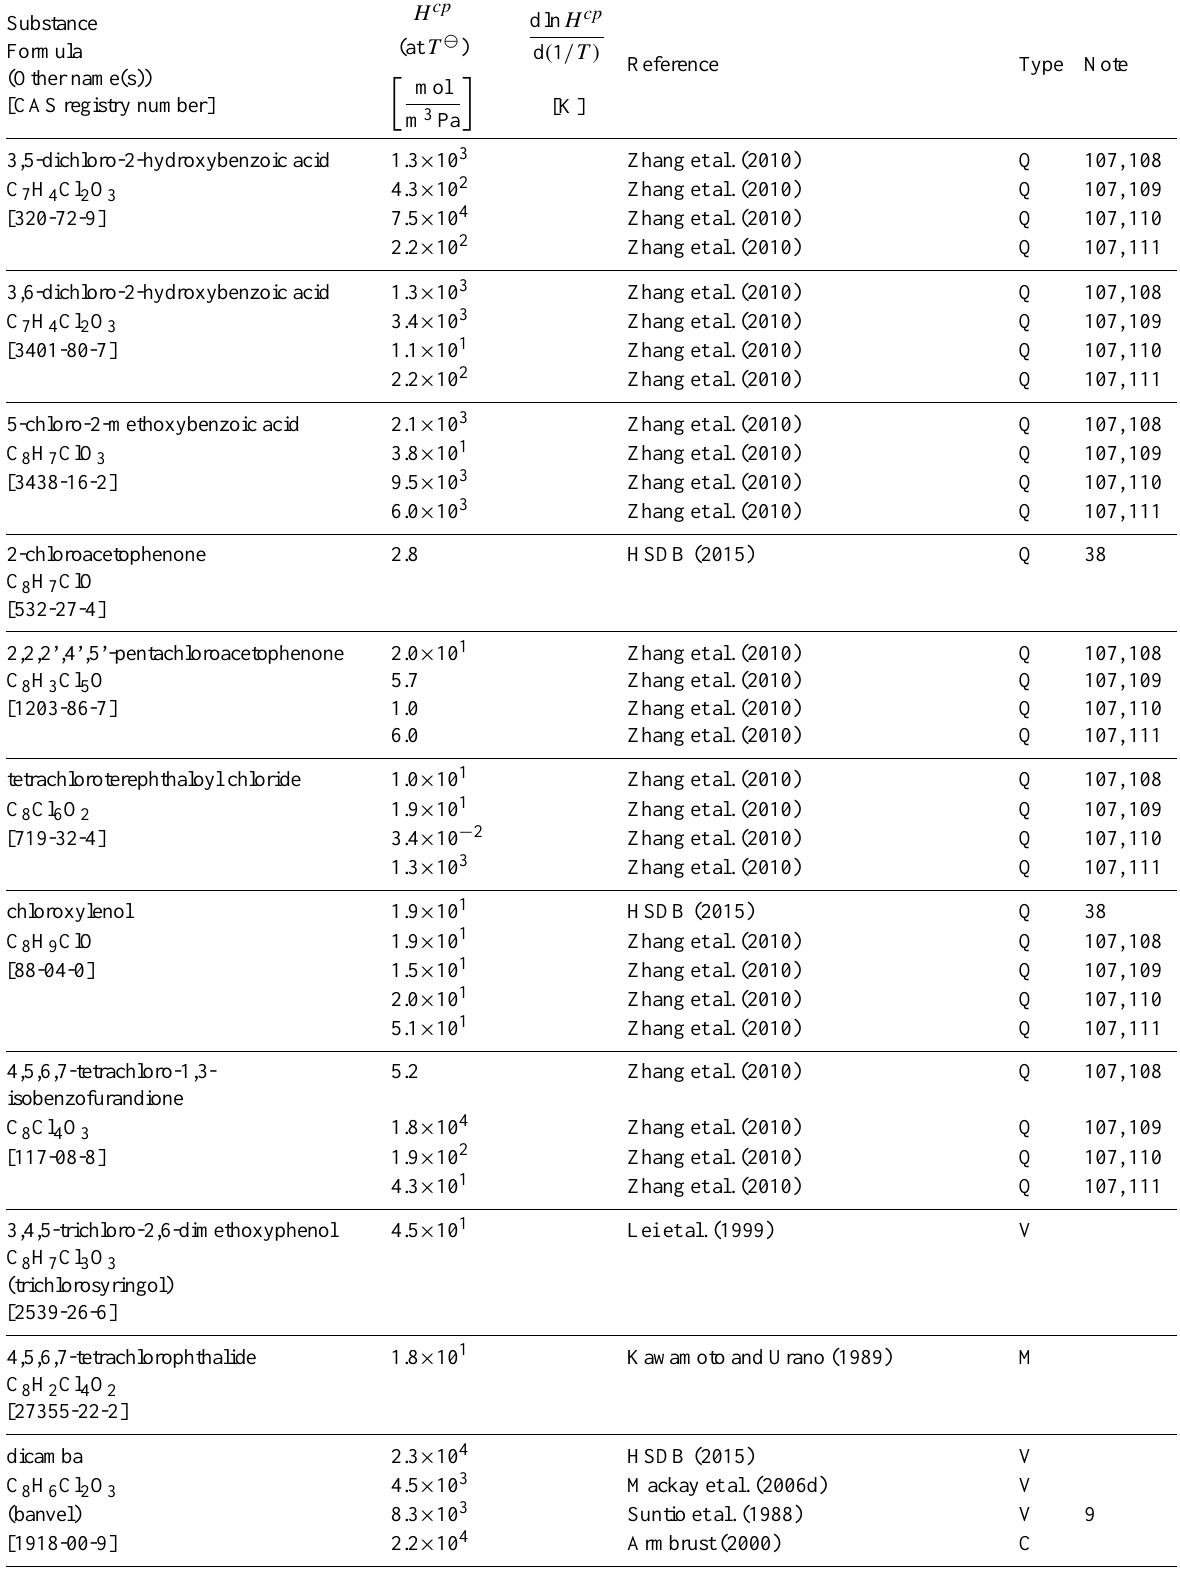
Table 6: Henry’s law constants for water as solvent